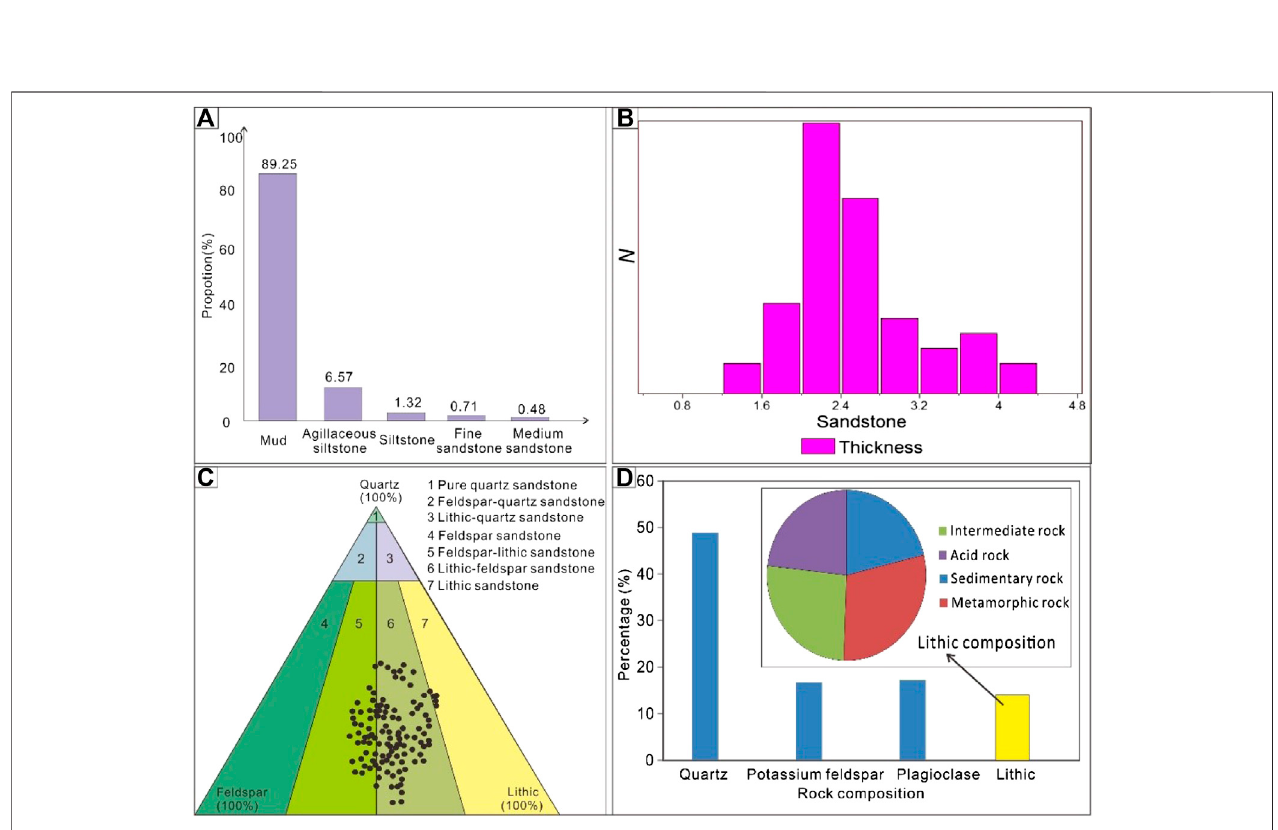
Frontiers in Earth Science |